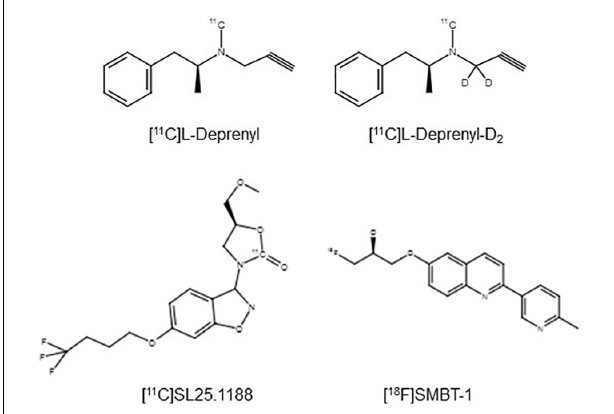
FIGURE 2 | Chemical structures of PET imaging agents for MAO-B applied in humans (Fowler et al., 1995; Bramoulle et al., 2008; Harada et al.,